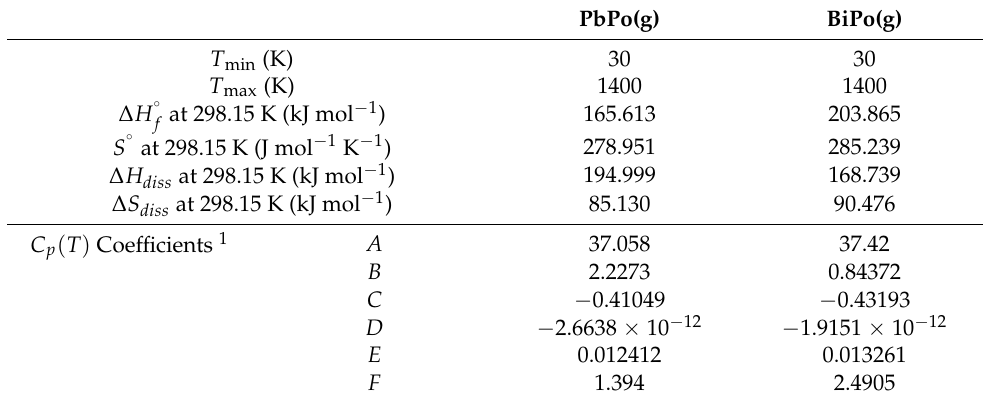
Table 3. Thermodynamic data for PbPo(g) and BiPo(g) based on results in Refs.